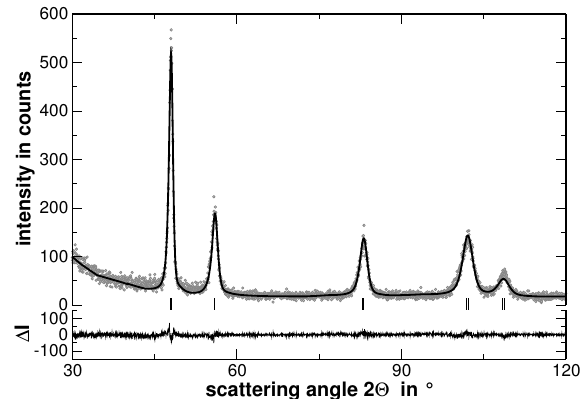
Figure 1. Experimental (points) and calculated (solid line) XRD patterns, as well as their difference ∆ I (lower part) of homogenized AuCuNiPt.